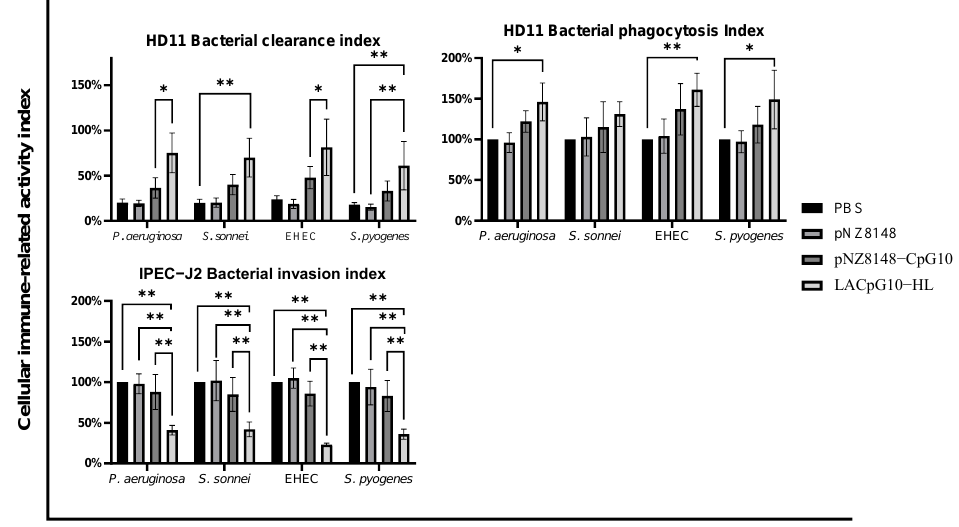
Figure 4. LACpG10-HL enhanced the antibacterial capacities of macrophages and enterocytes. HD11 and IPEC-J2 cells were pretreated with the stimulants for 30 h. Afterward, HD11 cells were co-cultured with pathogens at MOI = 1 and MOI = 10 to detect the corresponding bacterial clearance index and bacterial phagocytosis index. Meanwhile, IPEC-J2 cells were co-cultured with pathogens at MOI = 10 to detect the bacterial invasion index. Each column is represented with mean ± SD from three repeated experiments. Significant differences between different stimulants under infection of the same pathogen were indicated by “*” (* p < 0.05, ** p < 0.01).